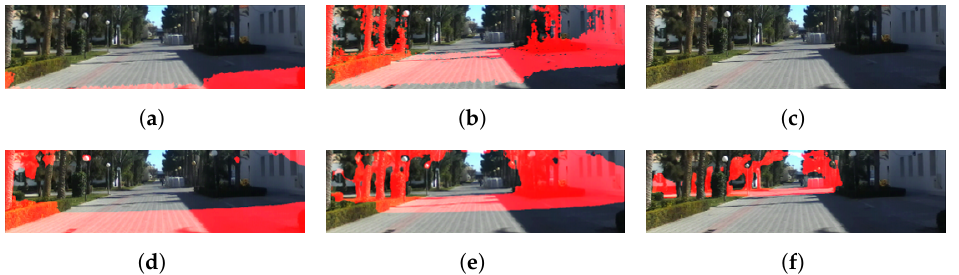
Figure 12. Depth estimation results using UASOL dataset. ( a ) Stereo depth 5 to 10 m, ( b ) stereo depth 10 to 20 m, ( c ) stereo depth 20 to 40 m, ( d ) depth fusion (5 to 10 m), ( e ) depth fusion (10 to 20 m), and ( f ) depth fusion (20 to 40